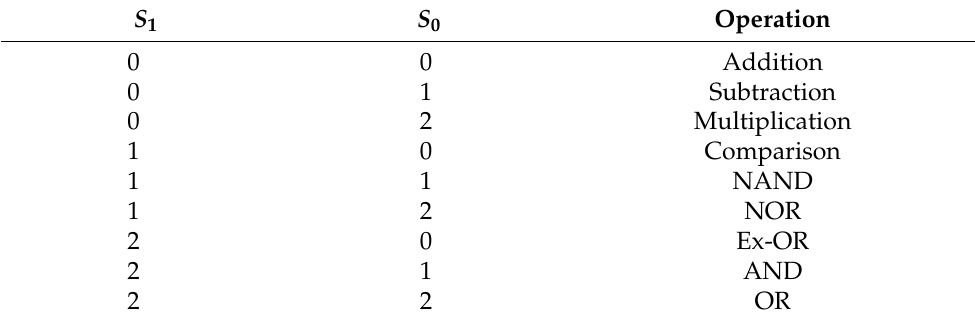
Figure 5. Schematic diagram of function select logic block [30]. Table 4. Functional table of ternary